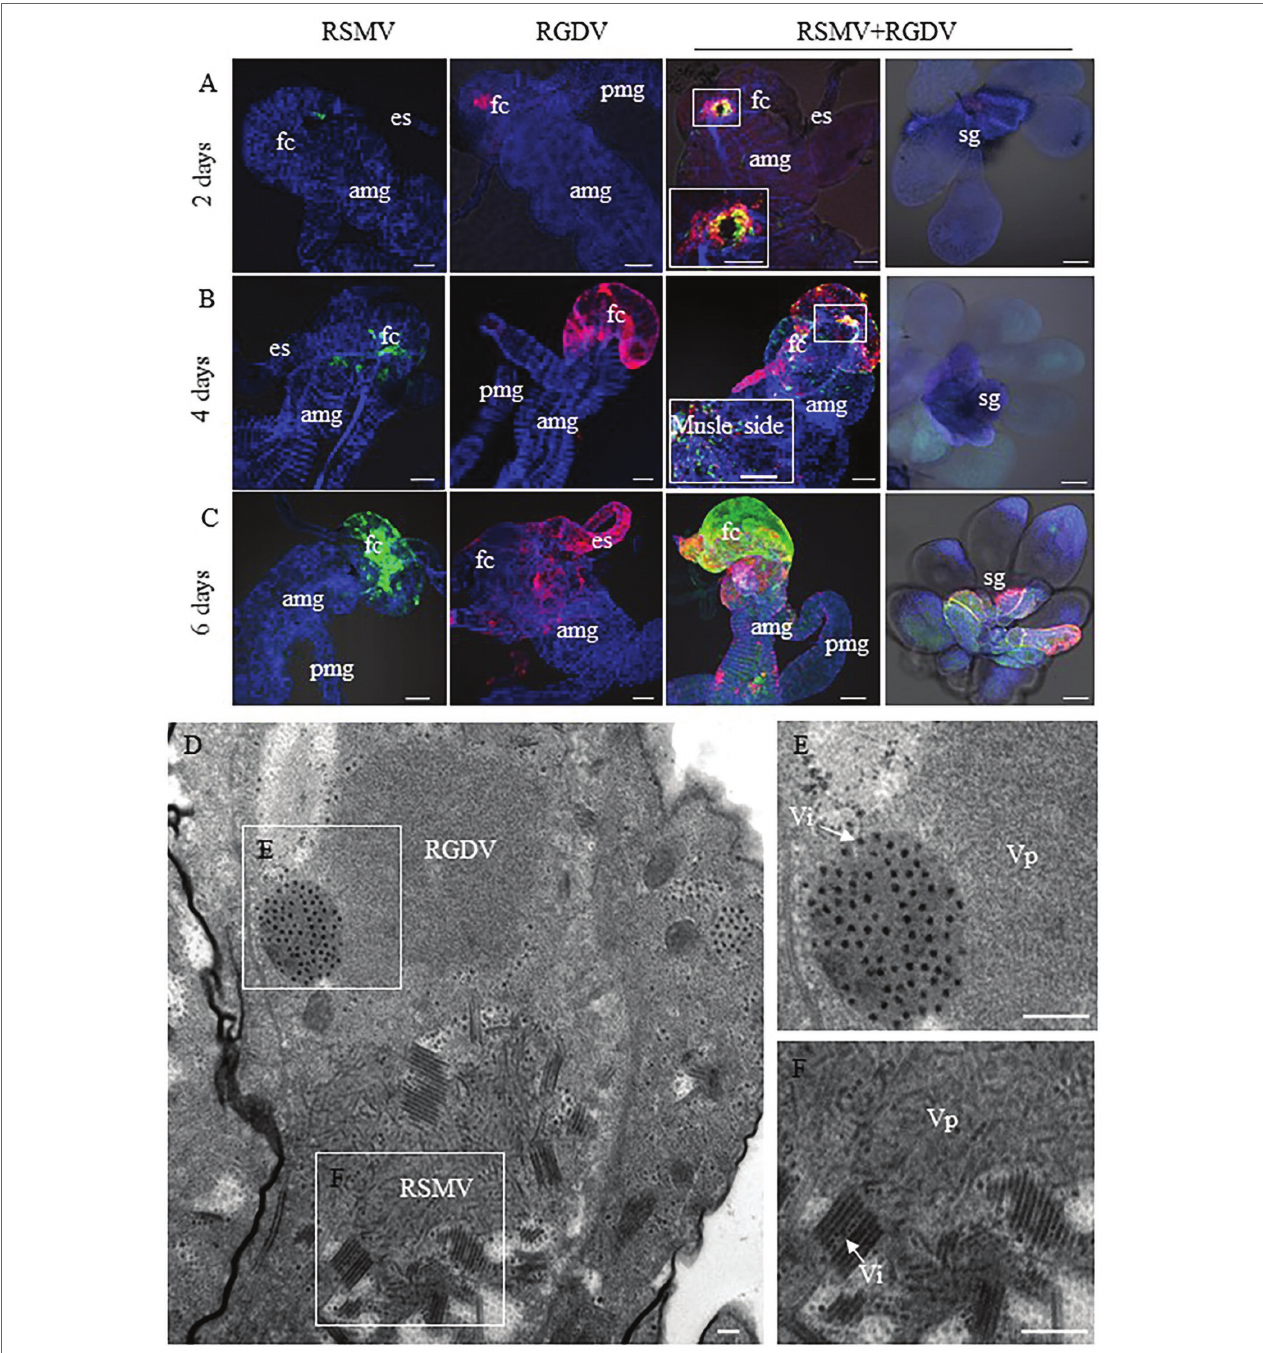
FIGURE 4 | Spread of RSMV and RGDV throughout R. dorsalis . (A–C) At 2 (A) , 4 (B) , and 6 (C) days padp, the internal organs or salivary glands of R. dorsalis singly infected with RSMV, RGDV or co-infected with RSMV and RGDV were stained with RSMV N–FITC (green), RGDV Pns11-rhodamine (red) and phalloidin–Alexa Fluor 647 carboxylic acid (blue) for examination by confocal microscopy. AMG, anterior midgut; ES, esophagus; FC, filter chamber; HG, hindgut; posterior midgut; and SG, salivary glands. Bar = 100 μ m. (D) Electron micrographs of virus in midgut of R. dorsalis co-infected with RSMV and RGDV. Panels (E,F) are enlargements of the boxed areas in panel (D) . Vp, viroplasm; Vi, viron. Bars = 100